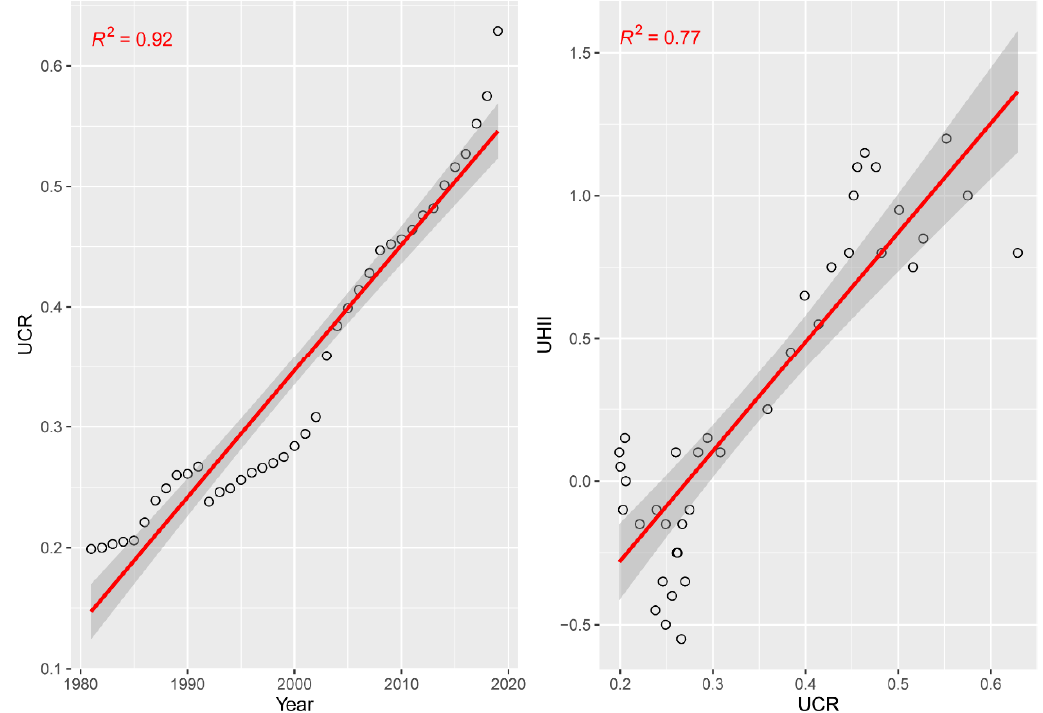
Figure 6. The plot of the urban compactness ratio (UCR) over the past 39 years versus time ( left ) and linear regression analysis of UCR to UHII ( right ).